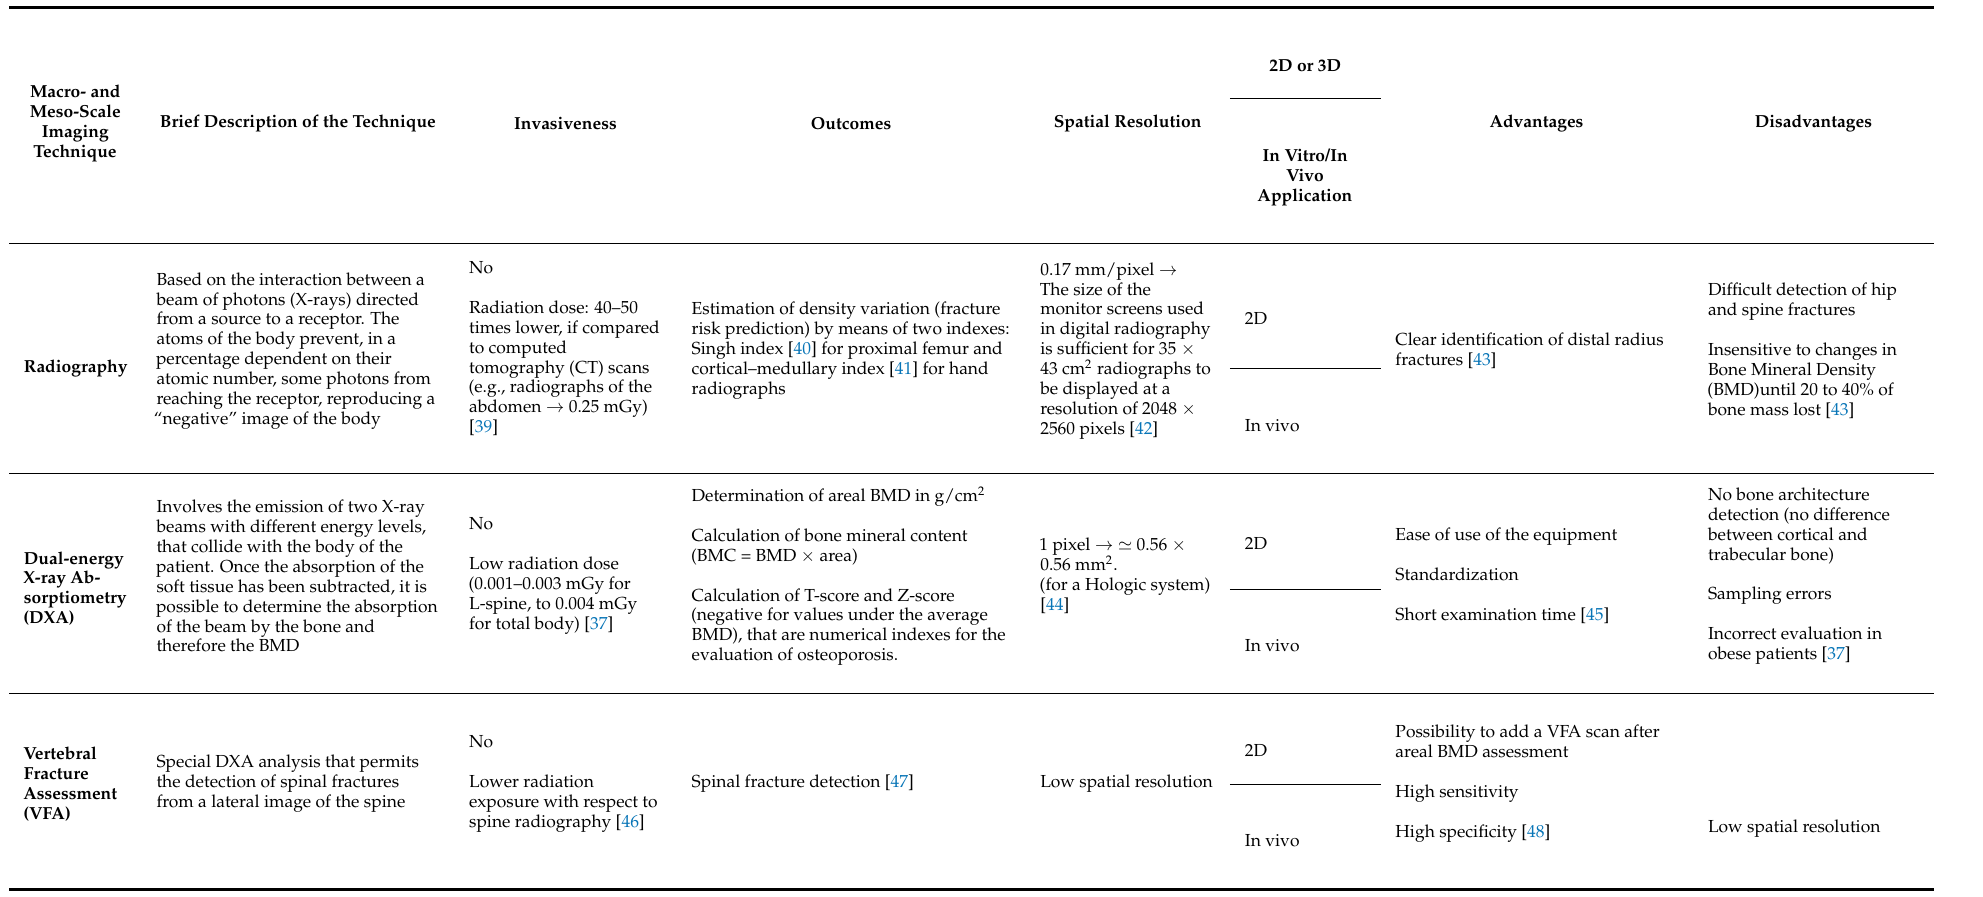
Table 1. Overview of the main macro- and meso-scale imaging